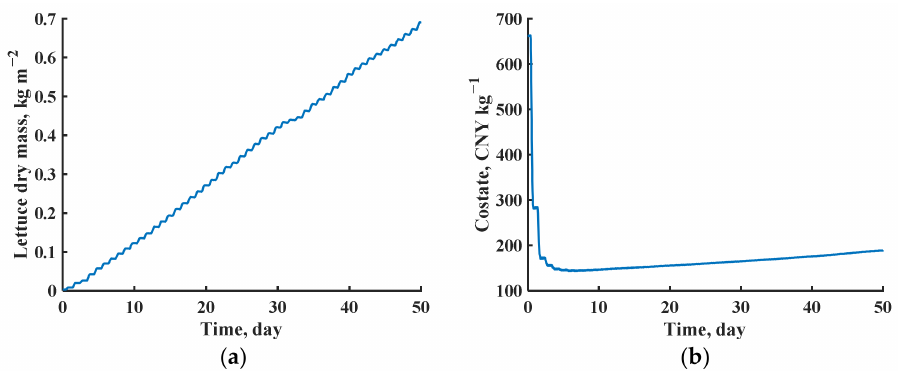
Figure 4. Crop state trajectory and costate trajectory. ( a ) Crop state trajectory, ( b ) Costate